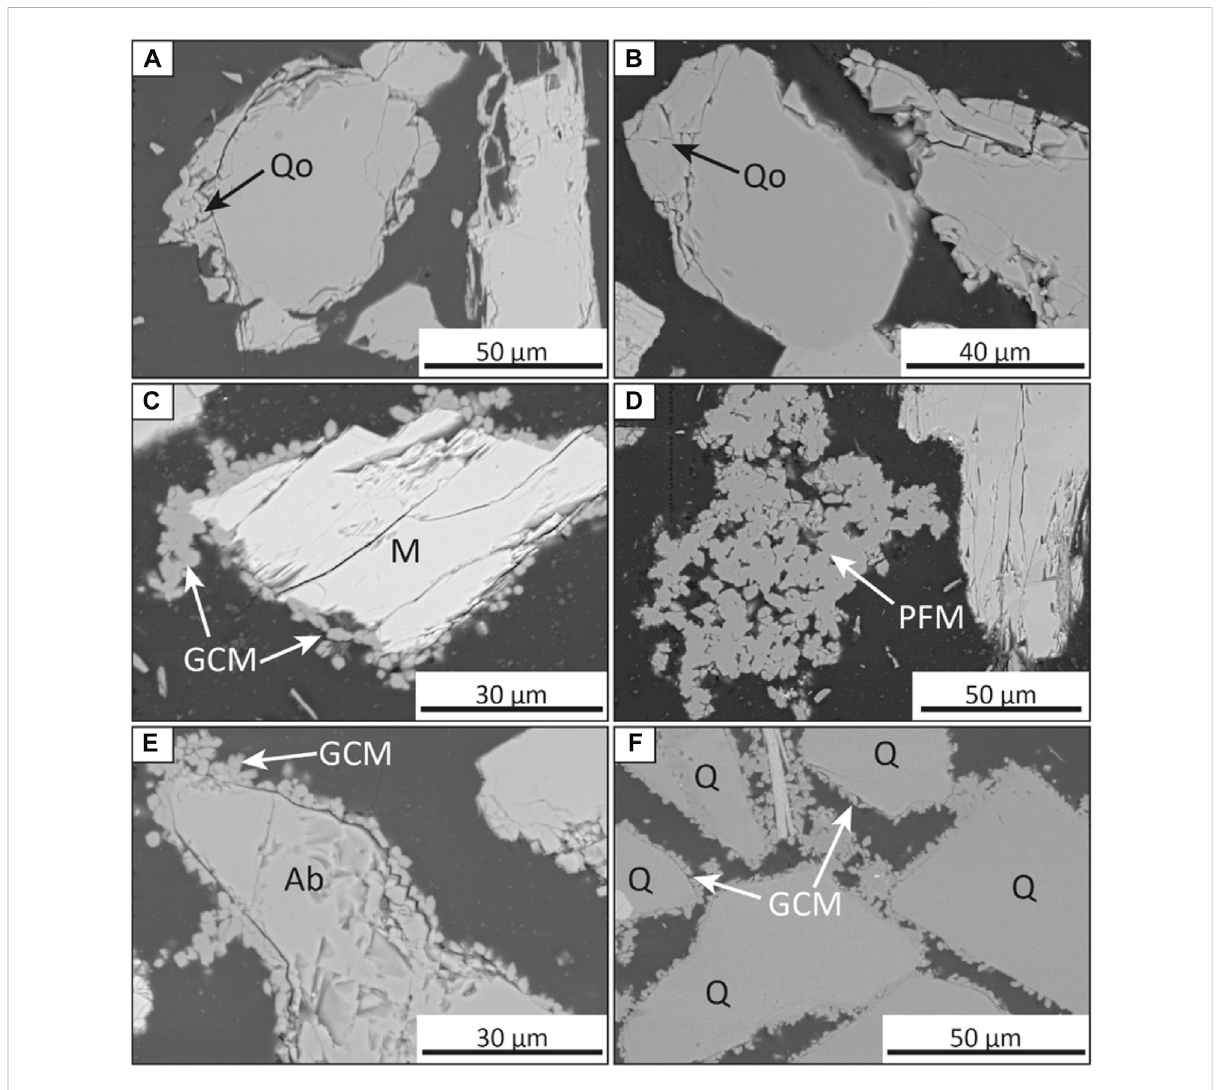
FIGURE 12 BSEimagesshowingexamplesofquartzovergrowths,grain-coating,andpore- fi llingmicrocrystallinequartzinthereactedsamplesoftheBute Inlet. (A) BSE image showing blocky quartz overgrowth (Qo) (Sample 2). The pointed/sharp edges of the overgrowth suggest authigenic origin. (B) BSEimageshowingtheformation ofblockyquartzovergrowth (Qo)ondetrital quartz(Sample2). (C) BSEimageshowinggrain-coatingmicroquartz (GCM) coating detrital mica (Sample 2). (D) BSE image showing the development of pore- fi lling microcrystalline (PFM) quartz destroying intergranularporosity(Sample2). (E) BSEimageshowingtheformationofgrain-coatingmicroquartz(GCM)rimmingdetritalalbite(Ab)(Sample5). (F) BSE image showing the precipitation of microcrystalline quartz coating detrital quartz (Q), preventing the formation of macro quartz overgrowth (Sample 5). (BSE, Backscattered